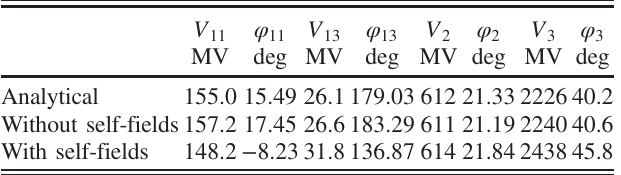
TABLE VII. The rf parameters for a charge of 500 pC com- pressed to 5 kA peak current.